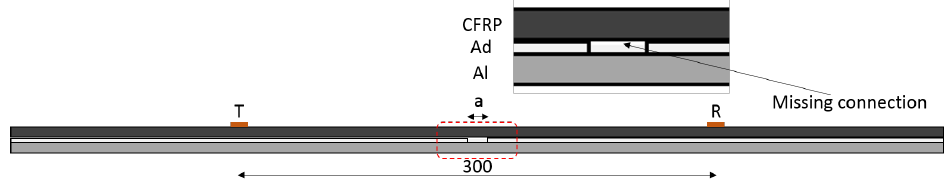
Figure 5. Sketch of the 2D FE model adopted to characterize the metrics vs damage size. The adhesive layer is intentionally